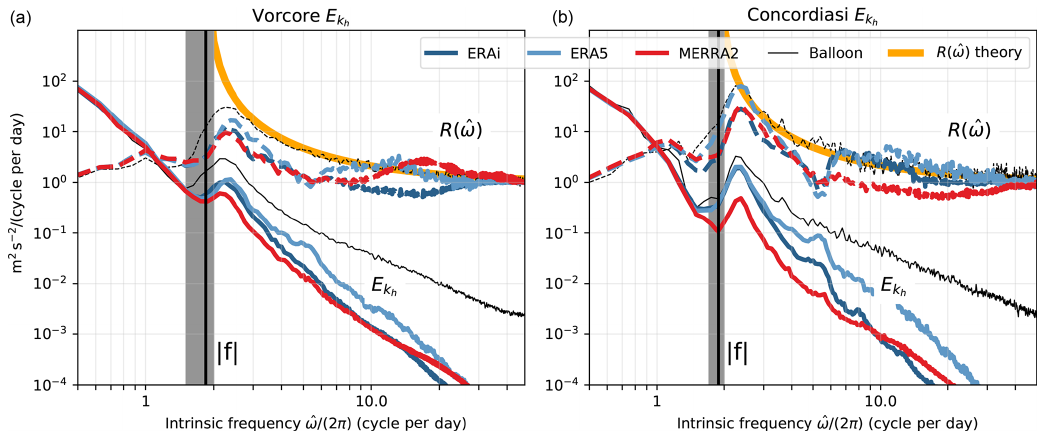
Figure 7. Intrinsic frequency spectra of horizontal kinetic energy per unit mass E k cordiasi (austral winter 2010, b ) campaigns. The black curve corresponds to balloon observations during the campaigns, while the spectra estimated from isopycnic trajectories in different (re)analyses are in color. The vertical black line indicates the mean Coriolis parameter | f | , while the shaded gray area depicts its variability along the balloon trajectories.